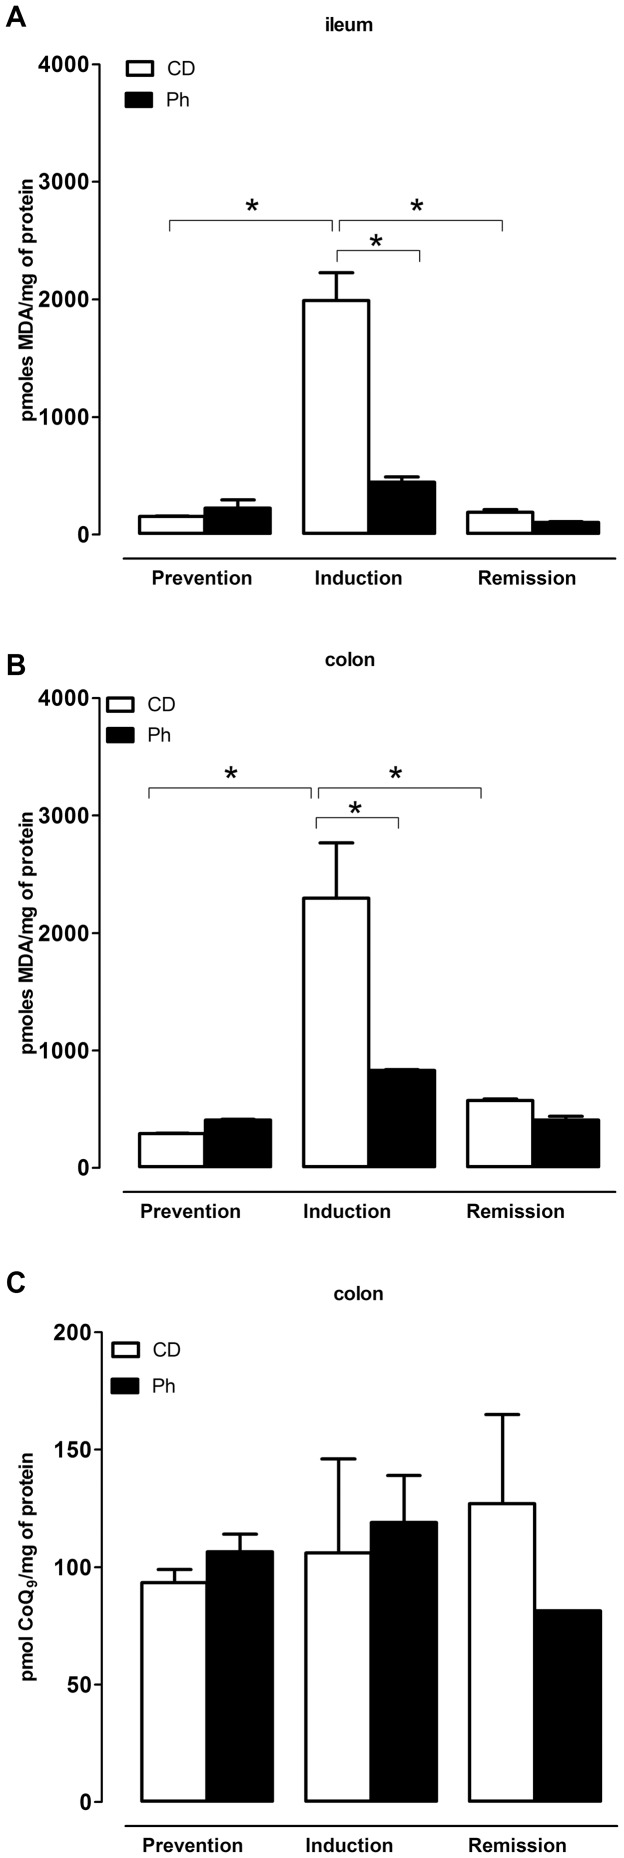
Assessment of acute colitis and evaluation of the response to Ph. Oxydative stress.MDA equivalents in ileum (A) and colon homogenates (B) White bars refer to CD and black bars refer to Ph treatment in the prevention, induction and remission period. In both ileum and colon, a strong oxidative stress is observed in the CD group in the induction phase, shown by a significant increase in MDA equivalents, prevented by Ph treatment (n = 4, *P<.001). The increase is significantly higher than in the prevention and remission phases (n = 4, *P<.001). C. Coenzyme Q9 levels in colon homogenate measured by HPLC. The ubiquinone content is not significantly different in all experimental conditions. Each tissue was analyzed in triplicate. Statistical analysis was performed by one way ANOVA test.